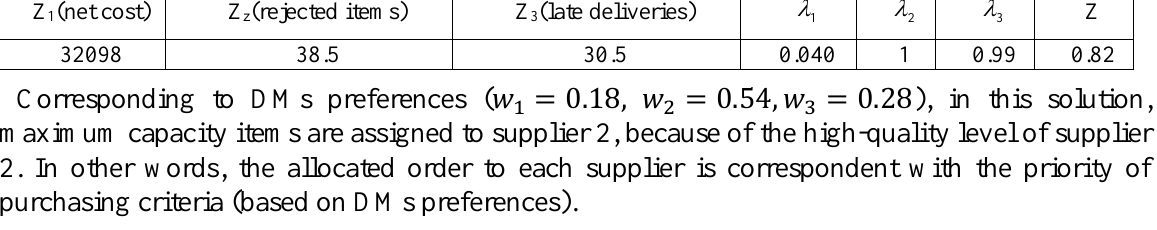
Table 3. Solution of numerical example ( 𝑤